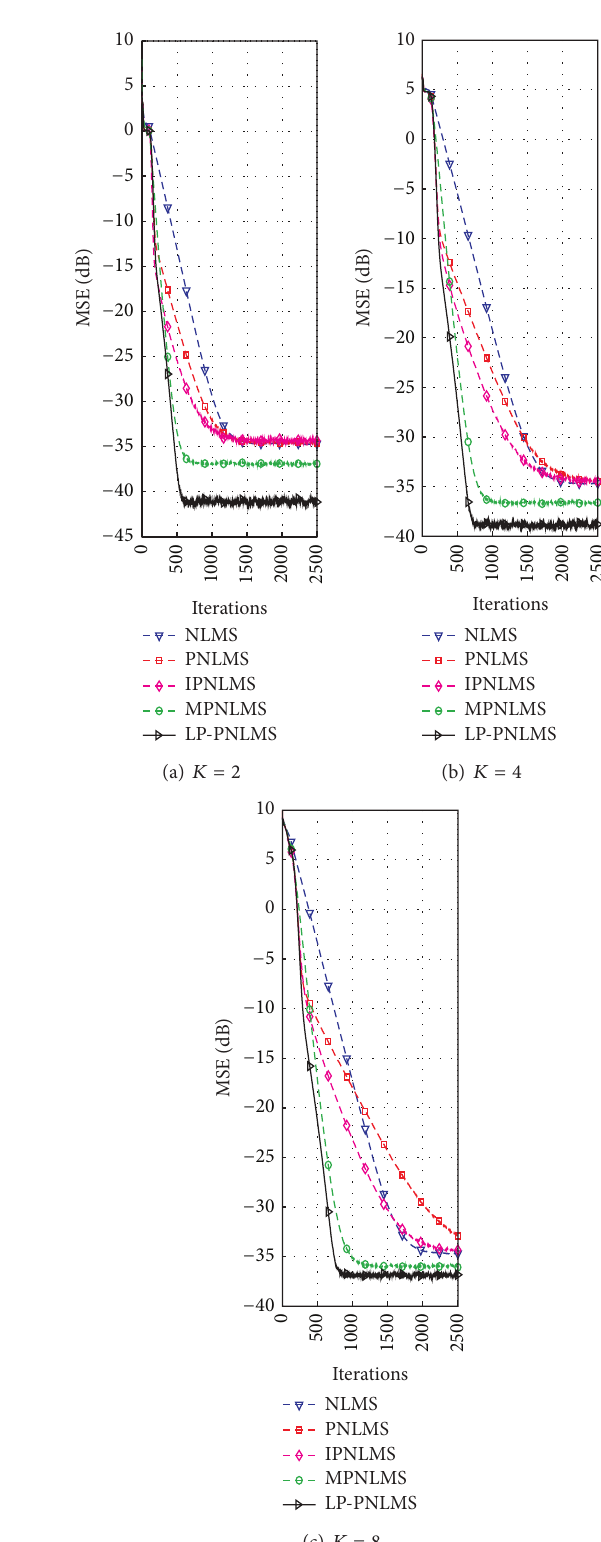
Figure 5: Effects of sparsity on the proposed LP-PNLMS algorithm for 𝑁 = 64 .